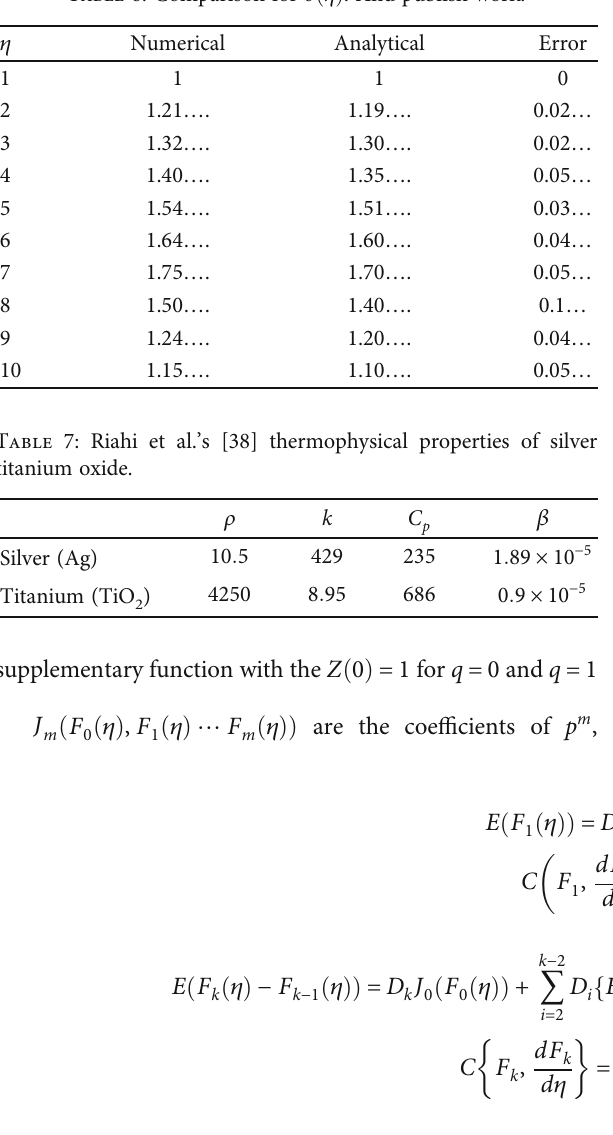
Table 6: Comparison for θ ð η Þ . And publish work.